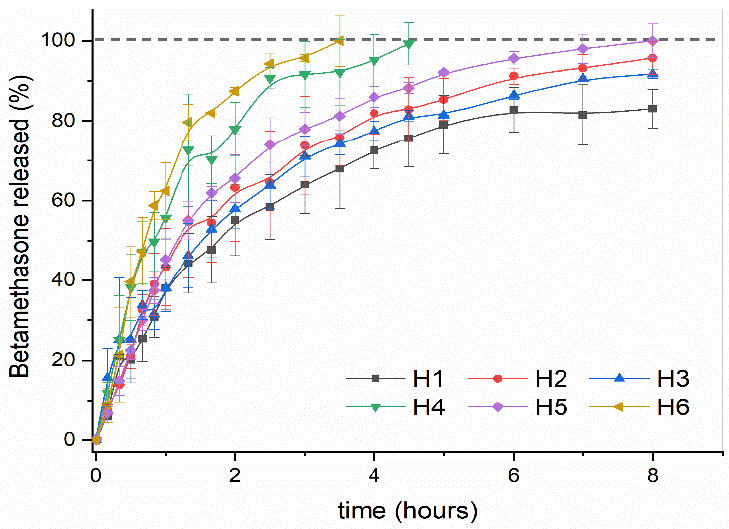
Figure 7. Cumulative in vitro release study of Betamethasone from AlgNa-g-poly(QCL-co-HEMA) hydrogels in PBS, pH = 7.4.